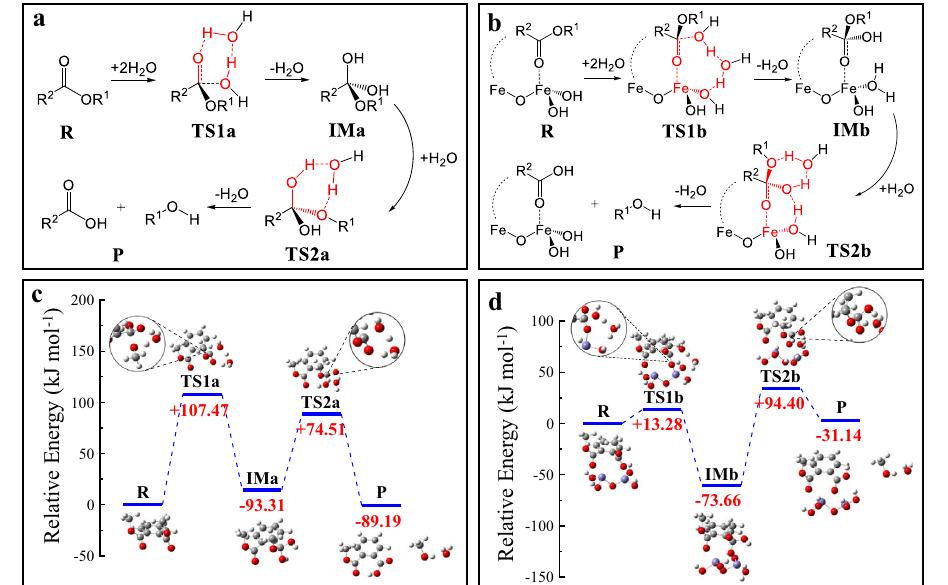
Fig. 6 | Schematic hydrolysis pathways. a , c The hydrolysis pathway of dimethyl phthalate (DMP) in neutral water by a two-step transition state (TS1 and TS2) mechanism. b , d The hydrolysispathwayofDMP after bidentate-coordinating with Fe 2 O(OH) 4 cluster, by a similar two-step transition state mechanism, as the